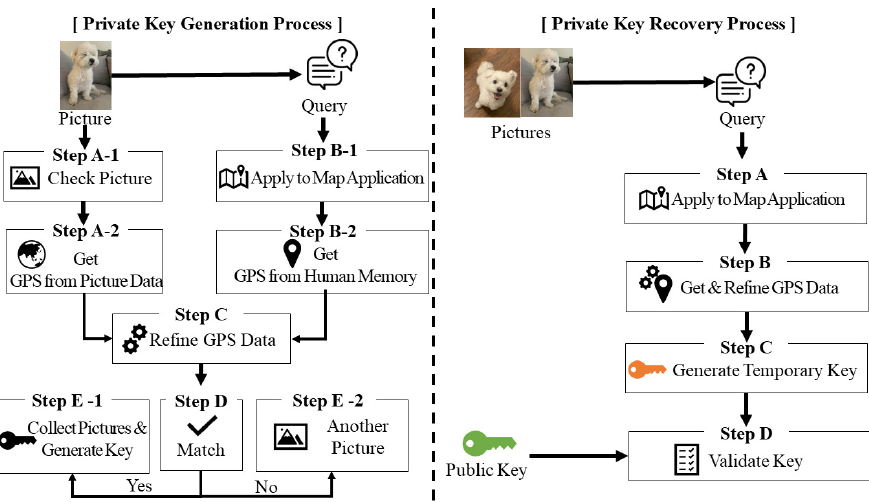
Figure 2. Process Overview.